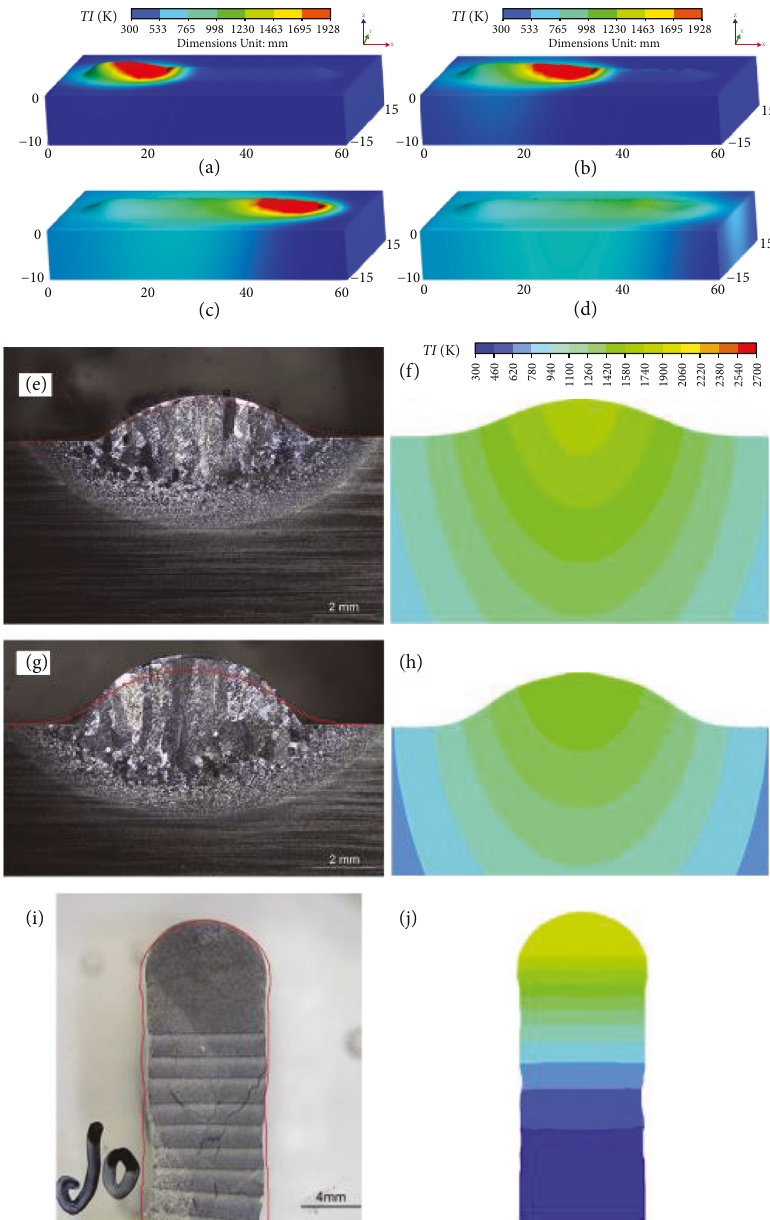
Figure 14: 3D views of molten pool and deposited bead during the 2nd layer deposition at different time: (a) t � 2.0 s; (b) t � 4.0 s; (c) t � 8.0s; (d) t � 10.0s. Comparison of cross-sectional profiles on x � 30mm plane: experimental profiles of (e) 1st layer, (f) 2nd layer, and (g) 21st layer; simulated profiles at 8.5s of (h) 1st layer, (i) 2nd layer, and (j) 21st